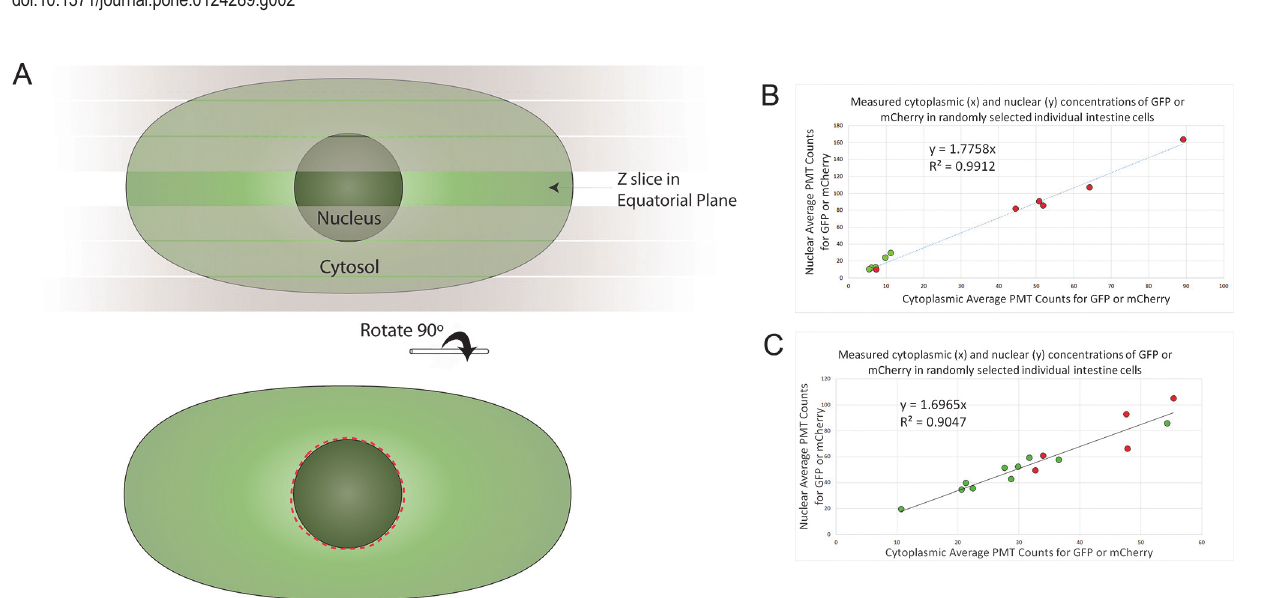
Fig 3. Quantification of single-cell expression by nuclear fluorescence signal. A) For each cell, from a confocal stack, we chose the z slice with the largest nuclear perimeter, then, using ImageJ, drew the nuclear boundary using the ellipse tool, and then used the selection brush tool to correct the boundary (approximated here by the red dashed line). We took the average pixel intensity inside these boundaries. Additional detail is shown in S7 Fig, which shows the proper identification of the nuclear equatorial plane in actual confocal micrographs. B) Relationship between cytoplasmic and nuclear concentration of fluorescent proteins in intestine cells. GFP or mCherry expression was driven by the daf-21 promoter in strains RBW2661 ( P daf-21 -GFP ) and RBW2642 ( P daf-21 -mCherry ), respectively. Cytoplasmic and nuclear concentrations of fluorescent protein were measured and plotted as x,y coordinates. Red dots are from mCherry expressing cells; green dots are from GFP expressing cells. We measured the nucleus as in A. To sample the cytoplasm, we measured a nucleus sized area of the cytoplasm in the same z slice as the equatorial plane of the nucleus, with care to avoid autofluorescent granules in the cytoplasm (S3 Fig). Three randomly selected intestine cells were measured in each of four different animals (12 cells total), two expressing GFP and two expressing mCherry. C) The relationship between cytoplasmic and nuclear concentration of fluorescent proteins in intestine cells of heat shocked animals is shown. GFP or mCherry expression was driven by the hsp-16 . 2 promoter in TJ3001 ( P hsp-16 . 2 - GFP ) or TJ3002 ( P hsp-16 . 2 - mCherry ) animals, respectively. Measurements were made as in B , but cytoplasmic measures were difficult because there was more autofluorescence in heat shocked animals ’ cells, and we had to sample a few more cells (15 cells total) to see a decent correlation due to this “ noise ” in the cytoplasmic measurements. P < 10 – 7 for the correlations in B and C .